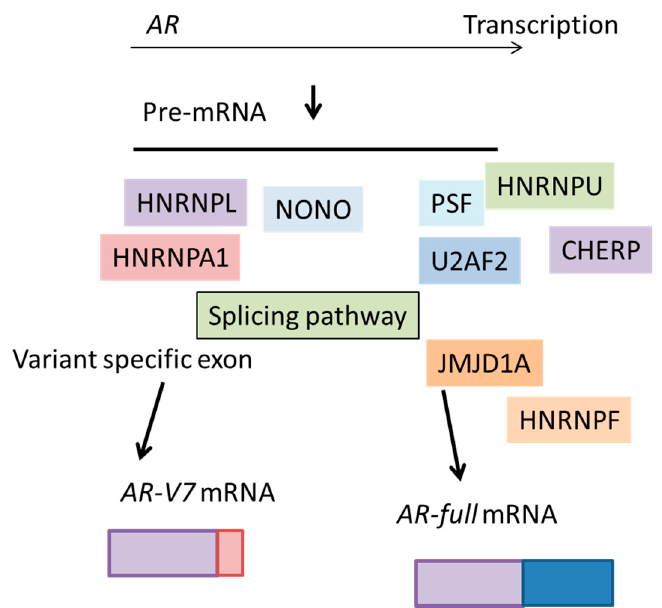
Figure 4. The essential role of various splicing factors for AR-V7 production. Pre-mRNA of AR is spliced by splicing factors upregulated in advanced prostate cancer. In prostate cancer, many splicing factors are transcriptionally induced to modifying the gene expression profile and induce cancer progression. Recently reported representative splicing factors are shown. JMJD1A: Jumonji domain containing 1A. HNRMPL: heterogeneous nuclear ribonucleoprotein L. HNRNPA1: heterogeneous